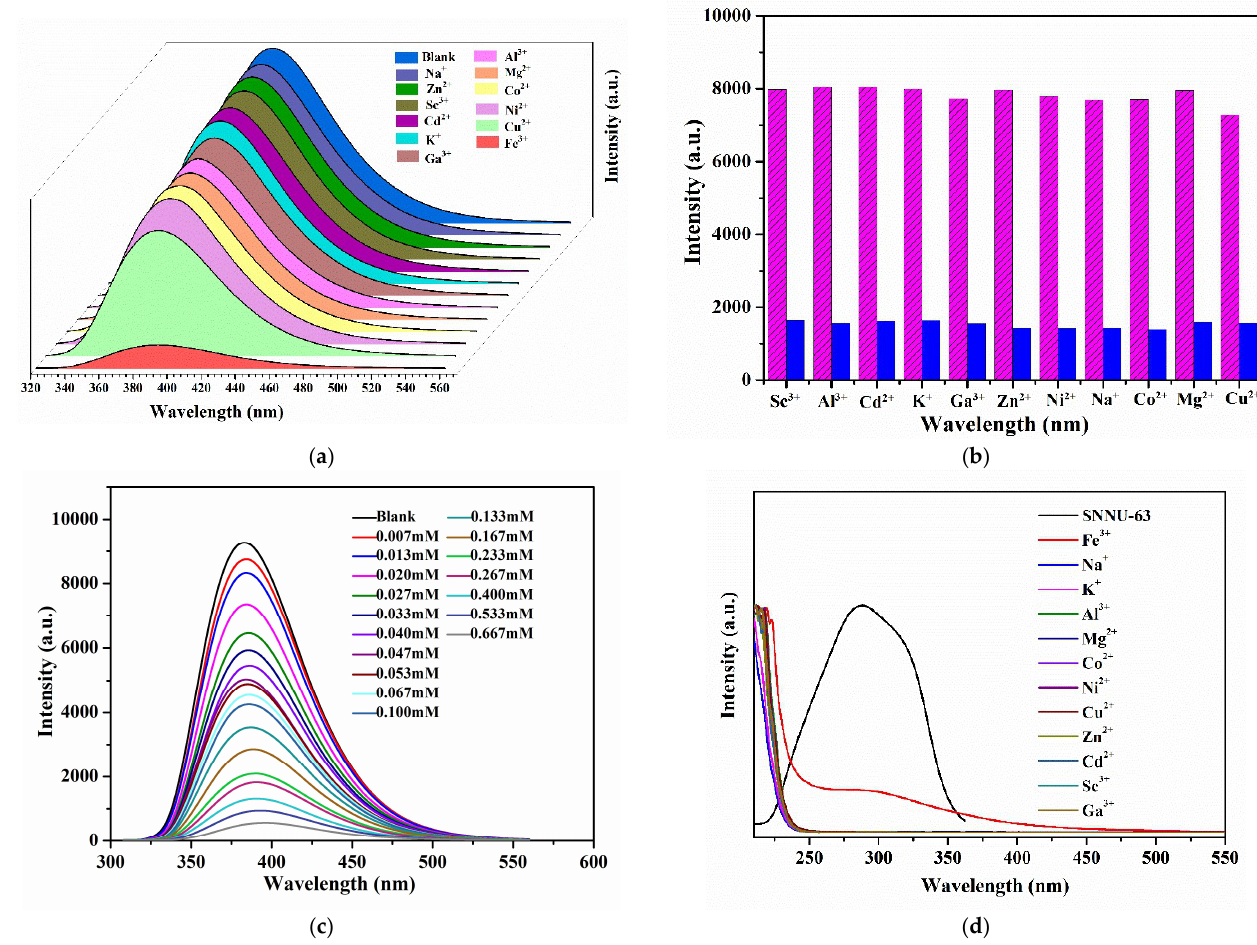
Figure 5. ( a ) Fluorescent spectra of SNNU-63 in the presence of 0.4 mM of different metal ions under an excitation of 288 nm. ( b ) The anti-interference performance of the coexistence of other metal ions and Fe 3+ ions for SNNU-63. ( c ) Luminescence spectra of SNNU-63 toward Fe 3+ ions with different concentrations of Fe 3+ ranging from 0 to 0.667 mM. ( d ) Luminescence excitation spectrum of SNNU-63 suspensions and UV-vis absorption spectra of twelve different metal ion